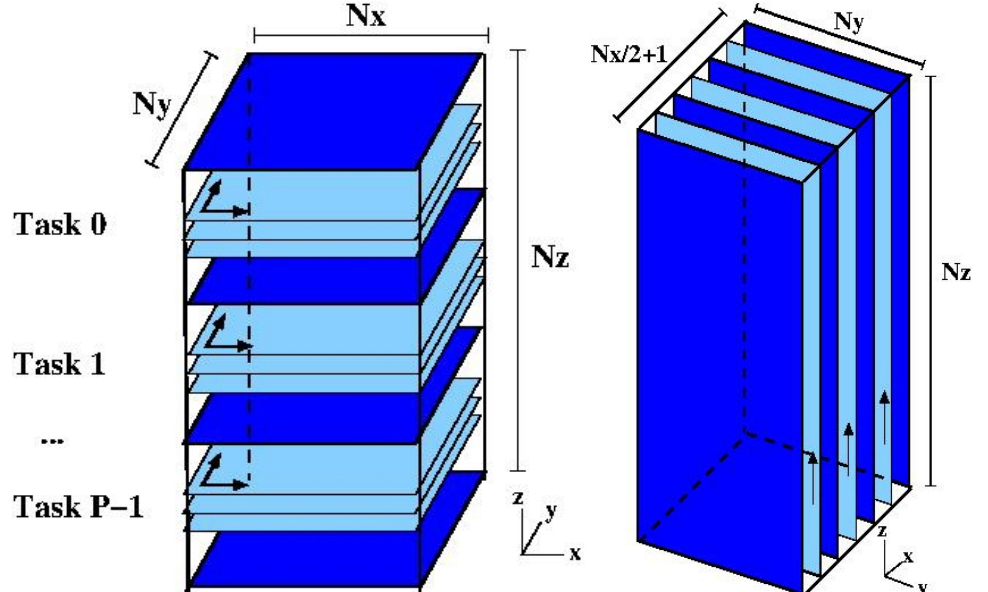
Figure 1. Schematic of the global grid and its 1D or slab-based domain decomposition used for the global Fourier transform. ( Left ) The real data block in physical space, together with the decomposition of the block among MPI tasks, where the dark shaded planes indicate MPI task boundary. This decomposition highlights the z -incompleteness (and x - and y -completeness) of the physical space data. The first step of the global transform is indicated by the arrows and represents a local 2D transform in each plane of the slab owned by the task, indicated by the lightly shaded planes. ( Right ) The original data block has been transposed in a second global transform step, so that the partially transformed data on the left is now z - and y -complete (and x -incomplete), in order that the final step in the global transform may be done: a final 1D transform done in the direction of the arrow for the data in each of the complex (shaded)